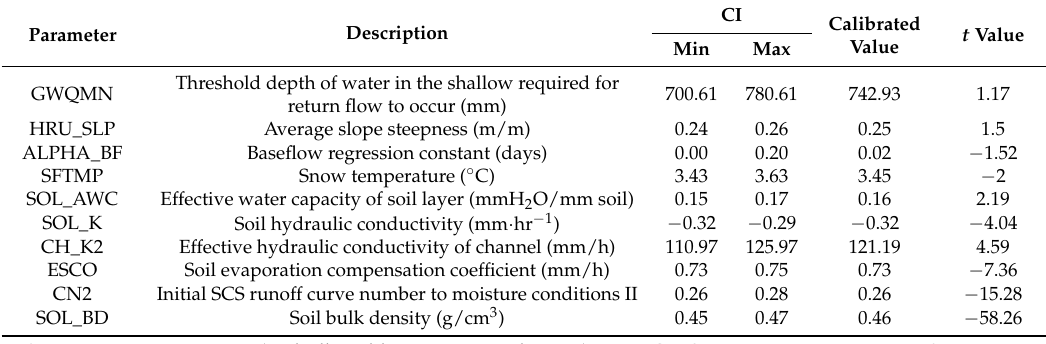
Table 1. Final value range of sensitivity parameters.